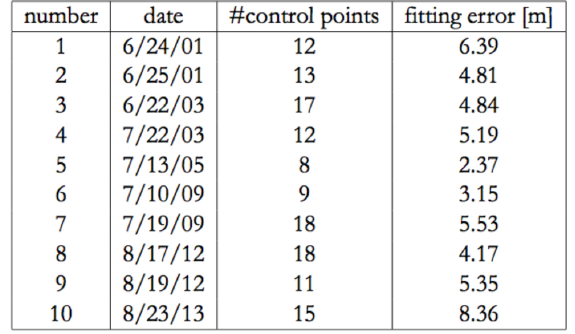
Figure 6. Statistics and errors of DEMs used in this study.